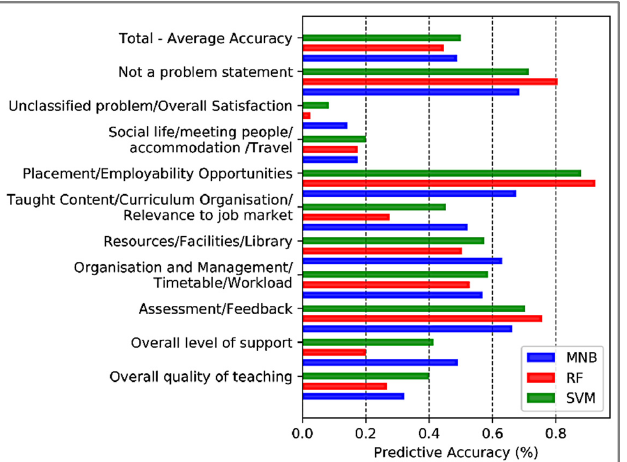
Figure 6. Predictive accuracy (%) of the Multinomial Naïve Bayes (MNB), Random Forest (RF), and Support Vector Machines (SVM) algorithms when applied to the evaluation sample of the NSS da-